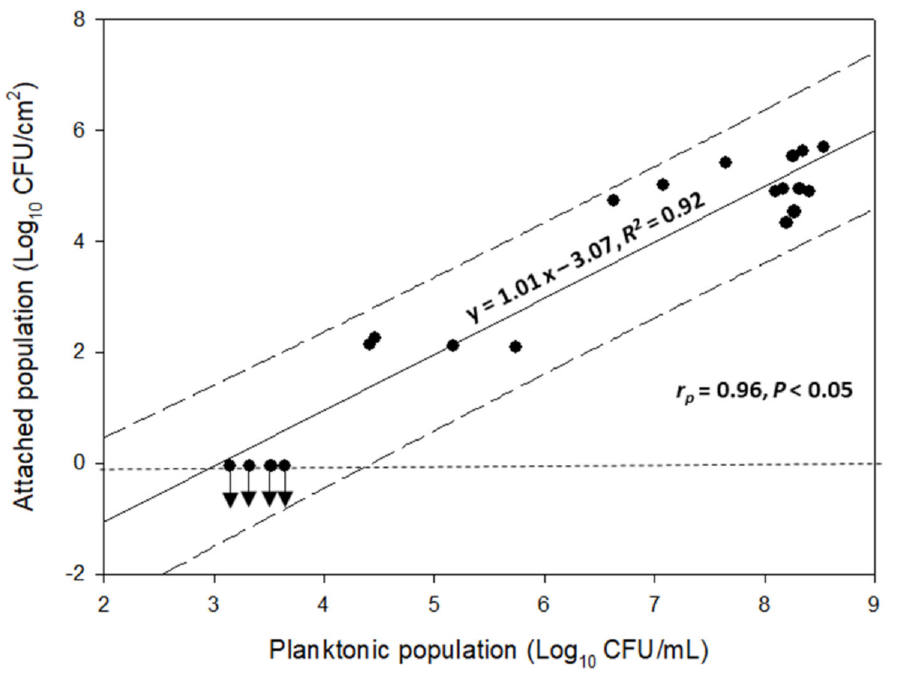
Figure 3. Correlation between the concentrations of the measured planktonic (Log 10 CFU/mL) and attached populations to the SS coupons (Log 10 CFU/cm 2 ) of the four-strain L. monocytogenes cocktail. The solid line represents the linear regression equation, while the dashed parallel lines represent the prediction intervals ( α = 0.95). The mathematical equation of the linear regression, together with its regression coefficient ( R 2 ), Pearson correlation coefficient ( r p ), and p -value are also presented. Dots represent the mean values of all experiments included in the CCRD ( n = 20; i.e., those shown in Table 1). For more clarity, the bars of standard deviations have been omitted. The horizontal dotted line illustrates the detection limit of the plate counting method of the sessile cells (i.e., − 0.05 Log 10 CFU/cm 2